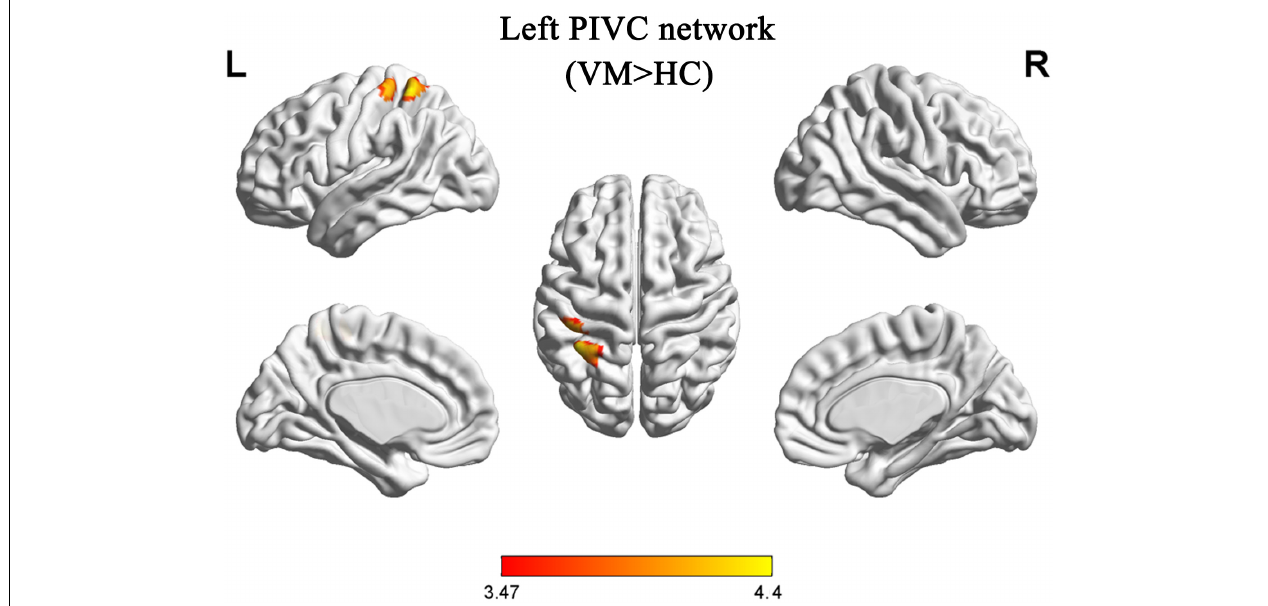
FIGURE 2 | Functional analysis results of the left parieto-insular vestibular cortex (PIVC) during the resting state in patients with vestibular migraine compared with healthy controls ( P < 0.05, Gaussian random field-corrected, with k > 33